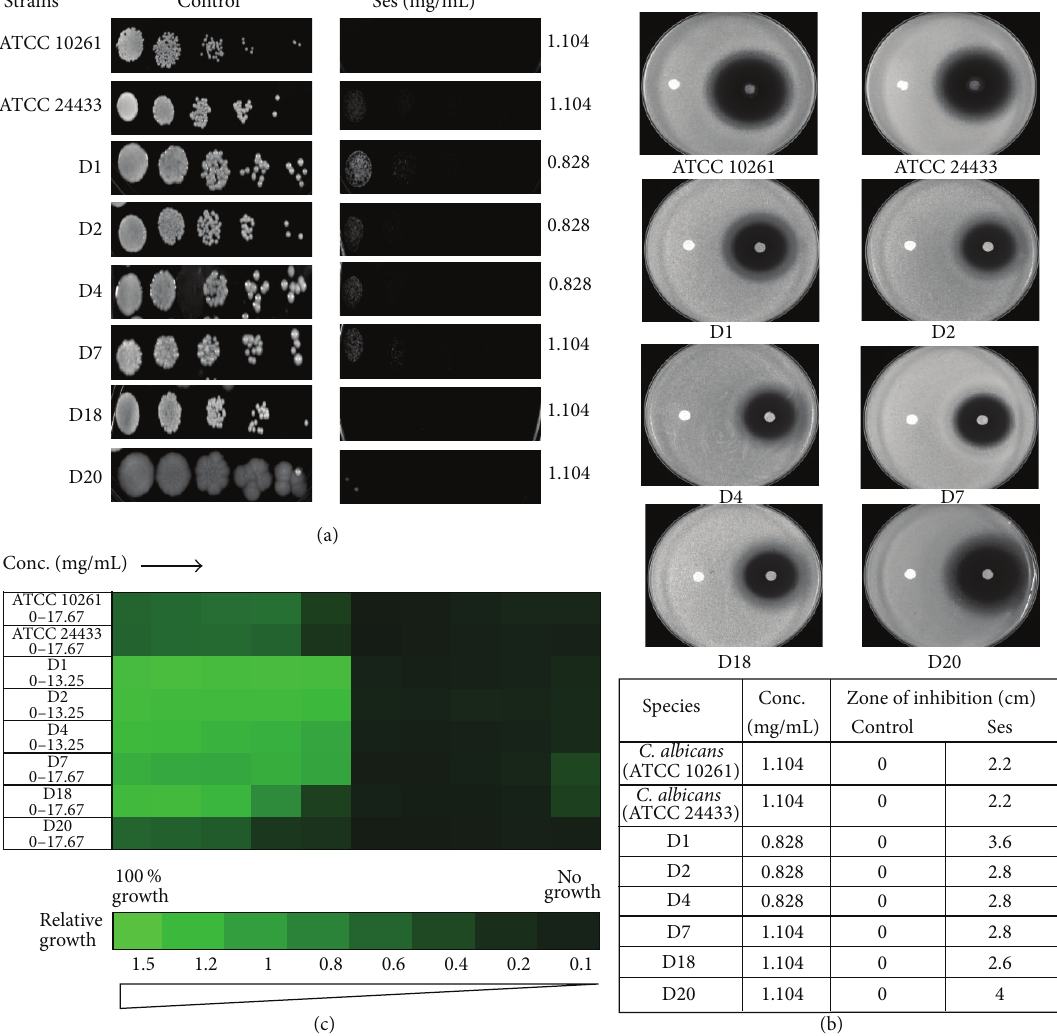
Figure 1: Drug susceptibility assays against C. albicans in the presence of Ses. (a) Spot assay of C. albicans reference strains (ATCC 10261, ATCC 24433) and clinical isolates (D1, D2, D4, D7, D18, and D20) in the absence (control) and presence of Ses. (b) Disc diffusion assay against C . albicans reference strains (ATCC 10261, ATCC 24433) and clinical isolates (D1, D2, D4, D7, D18, and D20) of C. albicans and their respective zone of inhibitions in the absence (control) and presence of Ses. For control, discs were spotted with the solvent of Ses described in Section 2. (c) Broth microdilution assay to determine the MIC 80 of C. albicans reference strains (ATCC 10261, ATCC 24433) and clinical isolates (D1, D2, D4, D7, D18, and D20) in presence of Ses. Data was quantitatively displayed with colour (see colour bar), where each shade of colour represents relative optical densities of the cell. The minimum drug concentration that inhibits growth by 80% relative to the drug-free growth control is indicated as MIC 80 for each